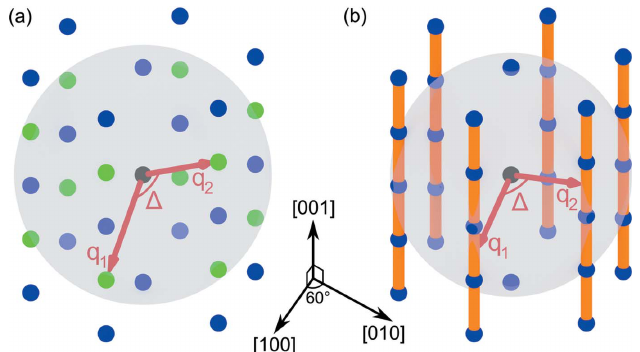
Figure 3 Models of 3D reciprocal space for ( a ) h.c.p. and ( b ) r.h.c.p. lattices. The black dot is the origin of reciprocal space, colored dots are the Bragg peaks. The semitransparent sphere shows the sphere S of the radius q = || q 1 || = || q 2 ||, at which the CCF is calculated. In ( a ) the green dots are the Bragg peaks intersecting the sphere S and, thus, contributing to the corresponding CCF at the angle (cid:2) . In ( b ), the orange rods represent the Bragg rods. They contribute to the corresponding CCFat the angle (cid:2) that is dependent on the radius q of the sphere S